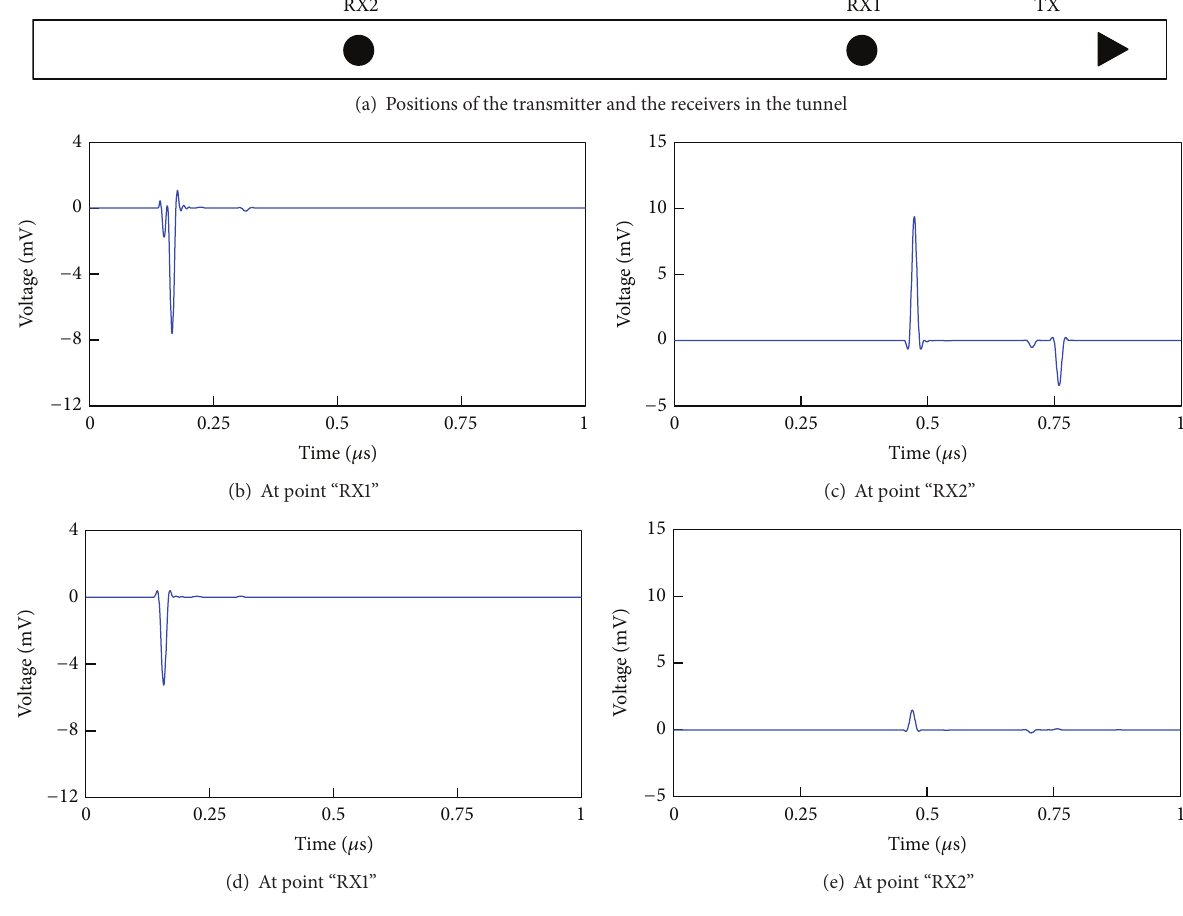
Figure 7: Received power levels in the second test tunnel. Table 1: Comparison of computation times for the tunnel structure with different level of discretization. Number of mesh